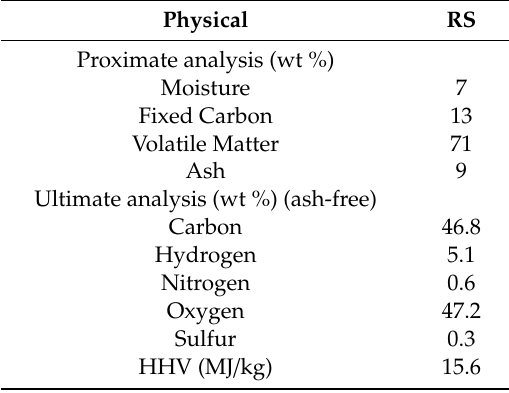
Table 3. Proximate analysis (PA), ultimate analysis (UA), and higher heating value (HHV) of lab-scale RS pellets.